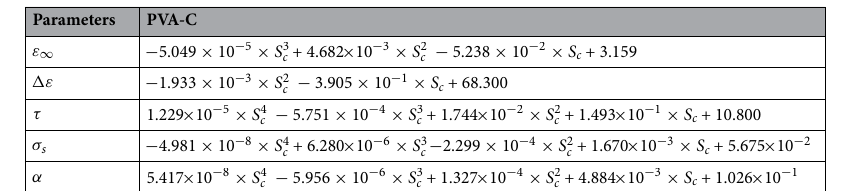
Table 2. Cole–Cole parameters dependent on the sucrose concentration for the fabricated phantoms.